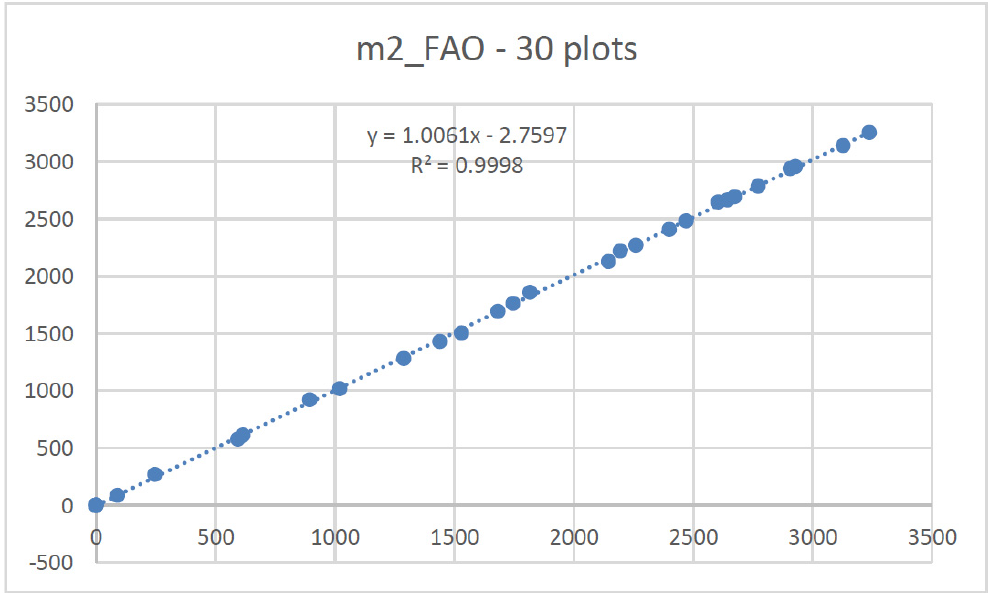
Figure A2. The reference area compared to the estimated forest area according to Method 2 for test plots (30 × 30 m 2 ) as defined by FAO/UN.